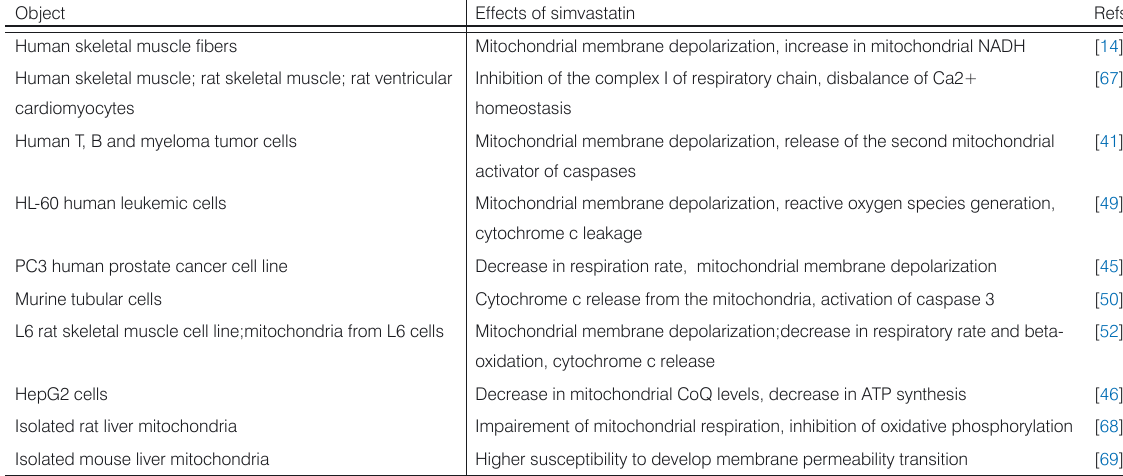
Table 4. Effects of simvastatin on mitochondria in vitro